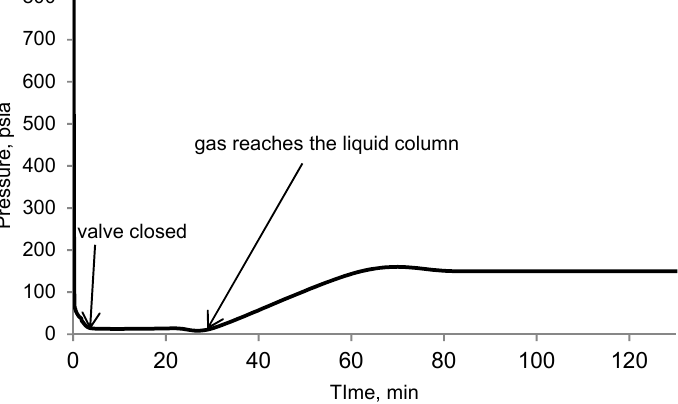
Figure 11. The casing pressure stays zero even when the valve is closed.